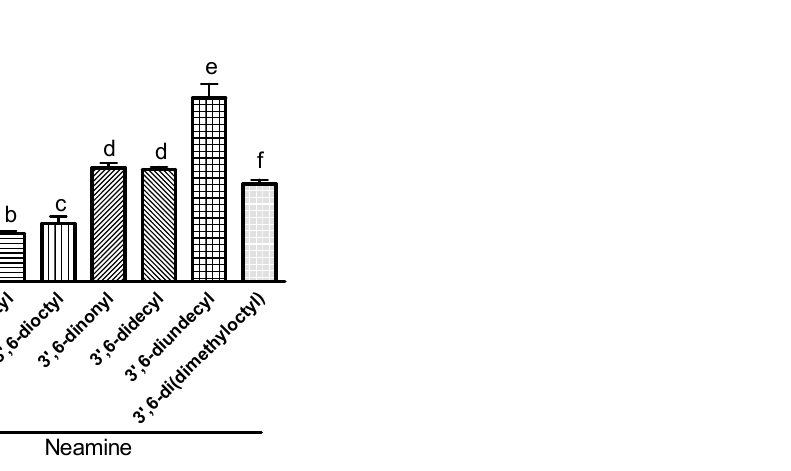
Figure 5. Effect of 3 ′ ,6-homodialkyl neamine derivatives on the micelle size distribution of LPS (5 μ g/mL) from P. aeruginosa in solution (10 mM Tris HCl buffer, pH 7.4). All the compounds were added to a final concentration of 10 μ M. Statistical assays were one-way ANOVA analysis with Tukey’s multiple comparison test. In each group, the bars with different letters indicate significant differences ( p < 0.001).